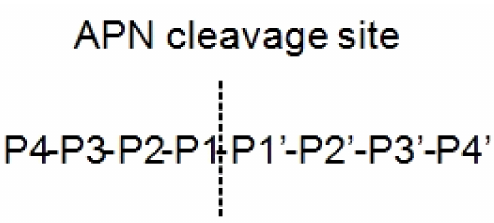
Figure 2. Nomenclature of the aminopeptidase N (APN) peptide substrates. The substrate is cleaved between the